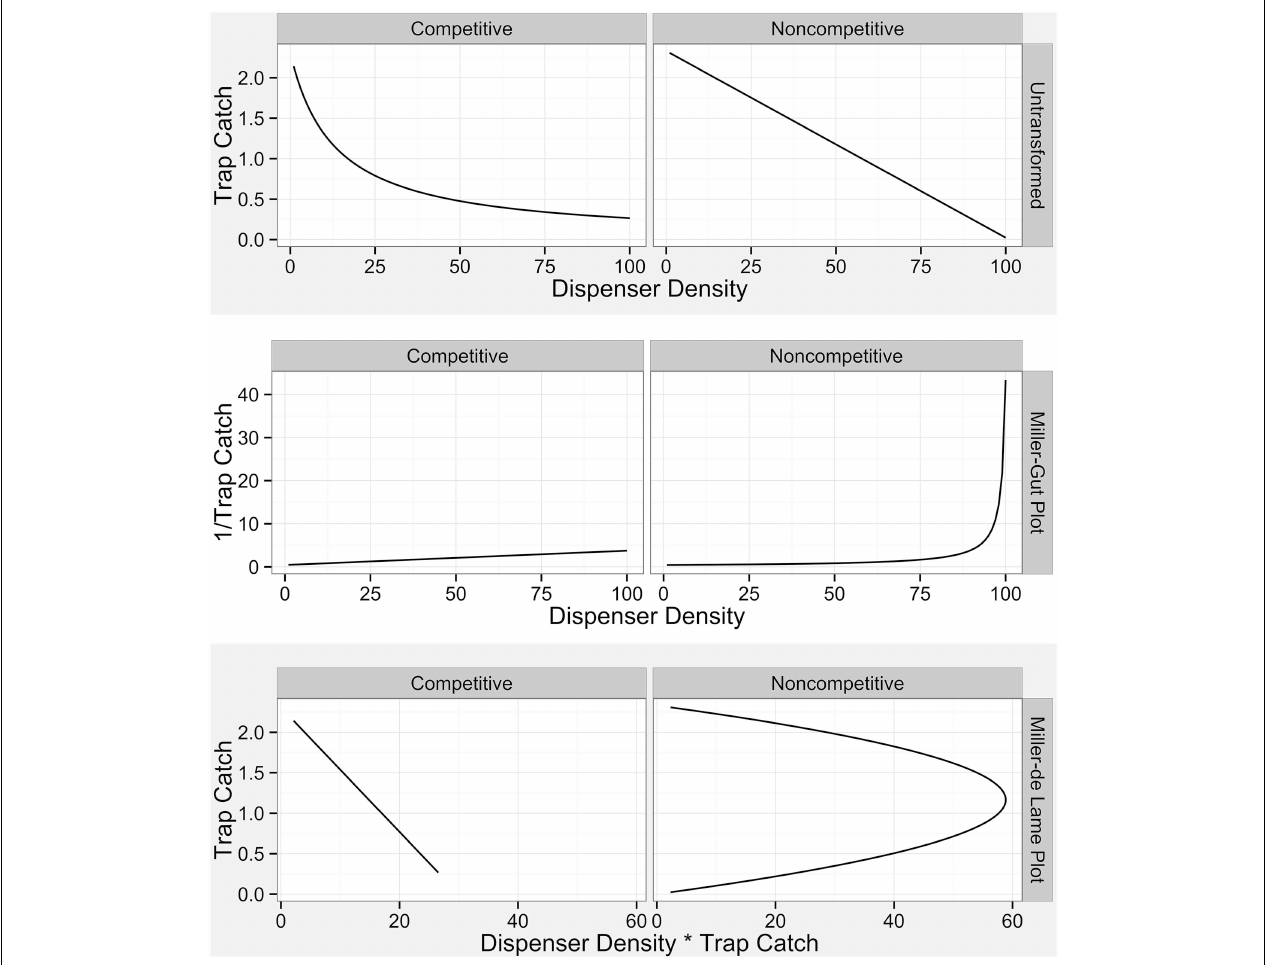
FIGURE 3 | Diagnostic plots for categories of mating disruption from Miller et al. (2006a). Competitive disruption profiles are established in Equation 1 of Miller et al. (2006a) and noncompetitive profiles are established in equation 16 of Miller et al. (2006a).